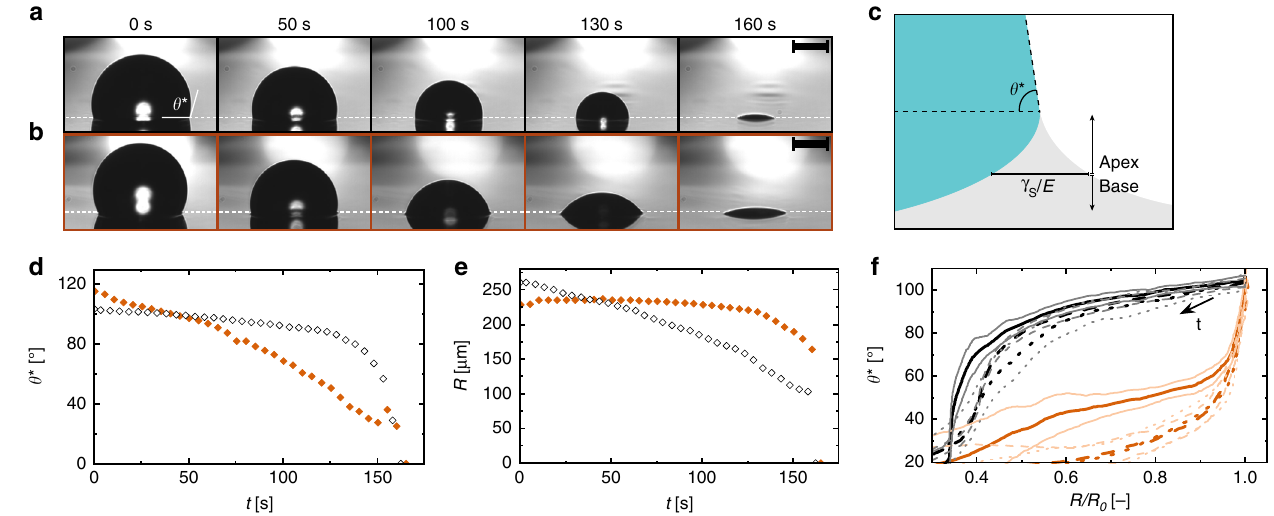
Fig. 1 Sessile droplets drying on rigid and compliant substrates. Image sequence of sessile droplets evaporating from, a rigid (PDMS Sylgard 184 9:1, E = 2937 kPa) and, b compliant (bottom-row, PDMS Sylgard 184 50:1, E = 20kPa 20 ) substrates (environmental conditions: rH = 50% and T = 24.1 ±0.5°C). Location of the temperature measurement, T , is shown in Fig. 2a. c Schematic of a droplet on a compliant substrate and resulting deformation. We de fi ned the apex region as the portion of the wetting ridge which has a width less than Υ S / E . d Experimentally measured apparent contact angle, θ * , vs. time, t , of the droplets in ( a ) and ( b ) (empty diamonds: rigid; fi lled diamonds: compliant). e Experimentally measured contact radius, R , vs. t of the droplets in ( a ) and ( b ) (empty diamonds: rigid; fi lled diamonds: compliant). f θ * vs. normalized contact radius, R/R 0 , where R 0 is the value of R at t 0 , for rH values of 15 ± 1% (dotted line), 50±1% (dashed line), and 90± 1% (solid line) on rigid (black) and compliant (red) substrates. Each line corresponds to the average of nine independent measurements; fi ne lines represent the standard deviations. Scale bar: a , b 200 µ m. Source data are provided as a Source Data fi le for ( d – f